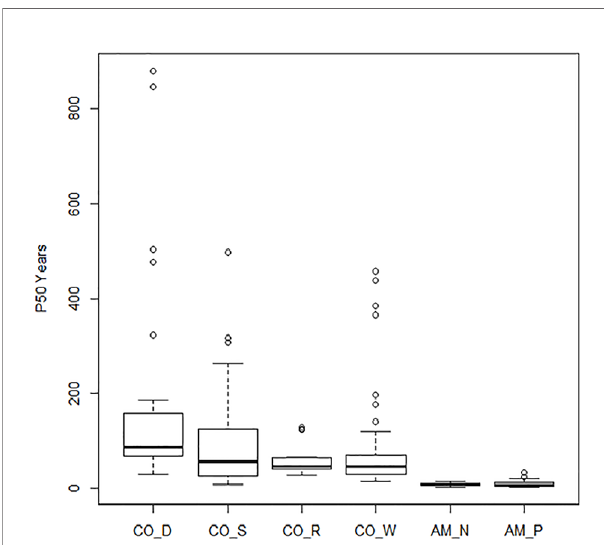
FIGURE 3 | The relationship between estimated P 50 (in number of years) and observed fi nal germination (in %) under after long-term cold storage in the four studies (CO_D, CO_S, CO_R, and CO_W) and not adjusted for storage time. Outliers with P 50 above 169 years were